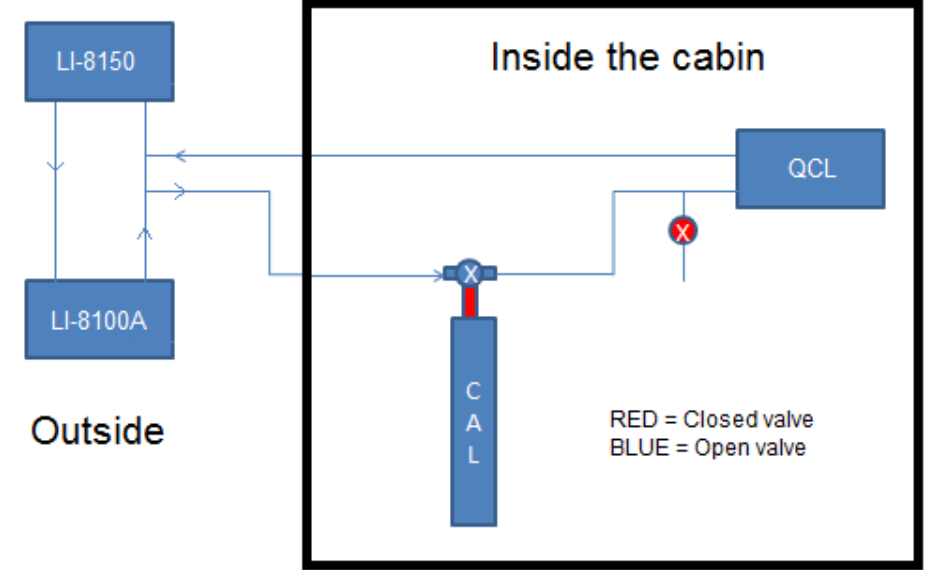
Figure 1. Setup of the QCL system and the Li-8100A / 8150. The QCL system and calibration gas cylinder (marked “CAL”) were placed inside the cabin and the LI-8100A and LI-8150 were placed outside. The setup is shown with the position of the valves during a chamber measurement. See Sections 2.3 and 2.4 for a further description.